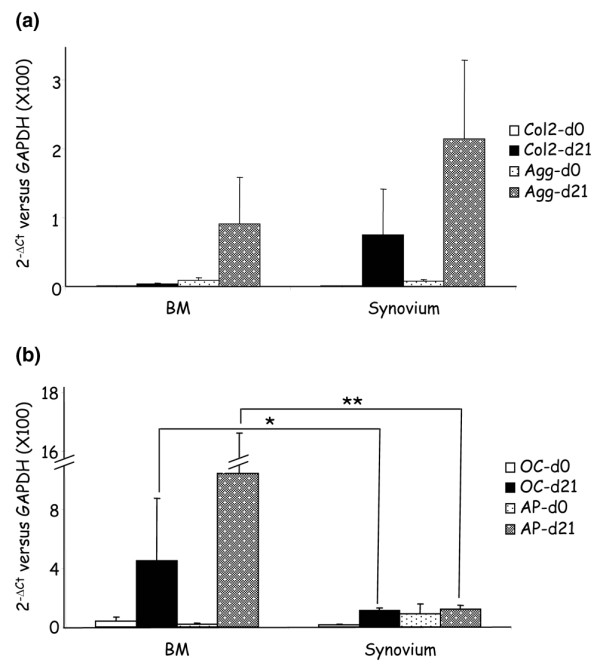
In-vitro-induced differentiation of bone marrow-derived and synovium-derived adherent cells. (a) Chondrogenic differentiation was evaluated after 21 days in micropellet culture. Expression of the specific markers for chondrogenesis (collagen type II [Col2] and aggrecan [Agg]) was determined by quantitative RT-PCR from the various samples: eight bone marrow (BM) mesenchymal stem cells (MSC) (four healthy, two osteoarthritis [OA], two rheumatoid arthritis [RA]) and eight synovium-MSC (four RA, two OA, two RA). (b) Osteogenic differentiation was evaluated after 21 days in monolayers. Expression of the osteogenic markers (osteocalcin [OC] and alkaline phosphatase [AP]) was determined by quantitative RT-PCR from the various samples: eight BM-MSC (four healthy, two OA, two RA) and eight synovium-MSC (four RA, two OA, two healthy). The expression levels were normalized on the basis of GAPDH expression, and the results are reported as ratios of the marker gene versus GAPDH using the formulae 2-ΔCt (×100) ± standard error of the mean. Statistics compared eight cell samples from BM and eight cell samples from the synovium. * P < 0.05, ** P < 0.01.